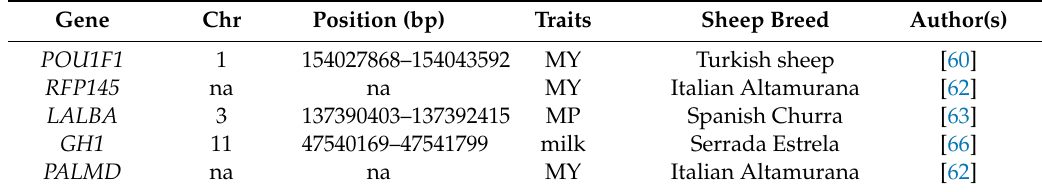
Table 4. Genes for milk yield